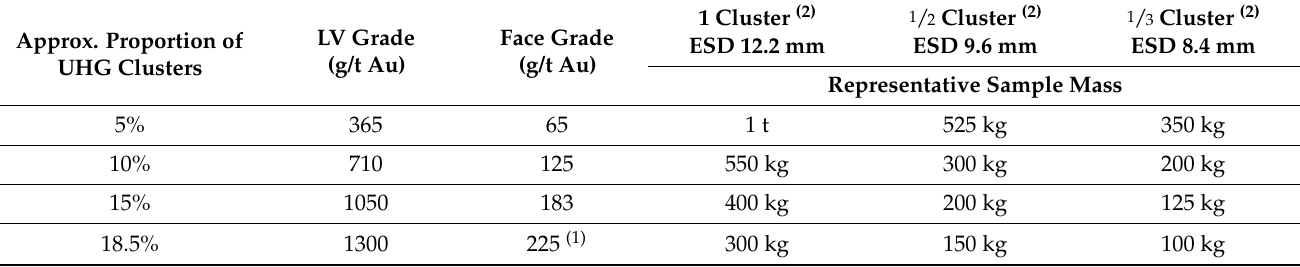
Table 18. LV only RSM values for ultra-high-grade cluster containing LV (0.7 m width). LV: laminated vein; ESD: equivalent spherical